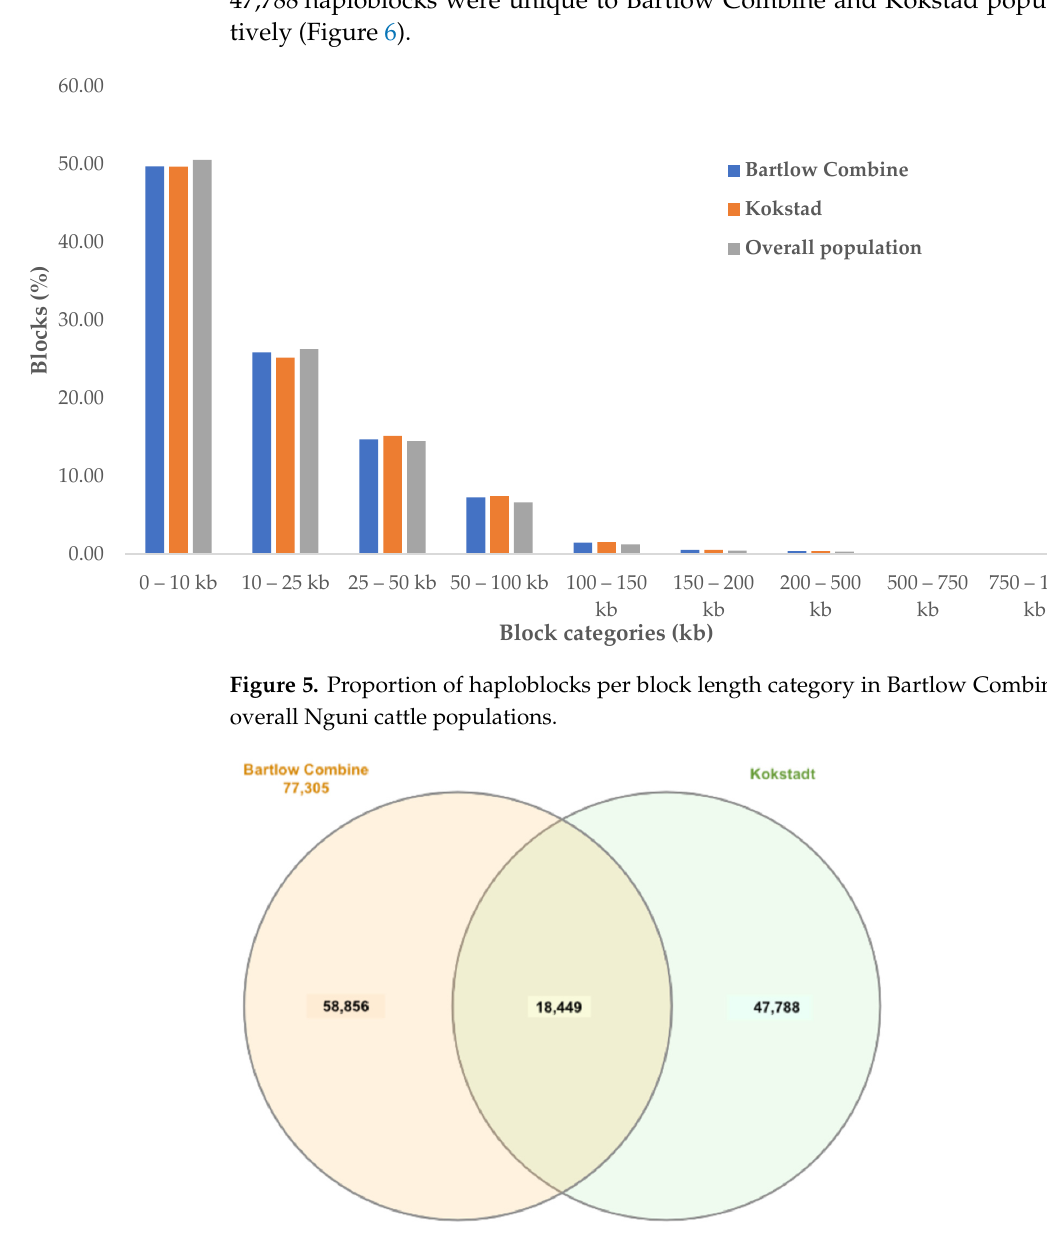
Figure 6. Venn diagram of shared and unique haplotype blocks between Bartlow Combine and Kokstad Nguni populations.